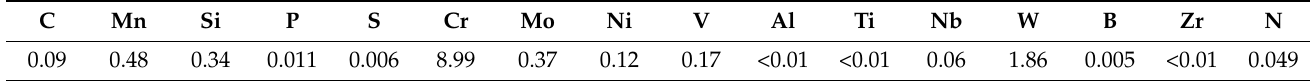
Table 2. Chemical analysis (%) of the P92 tube batch.